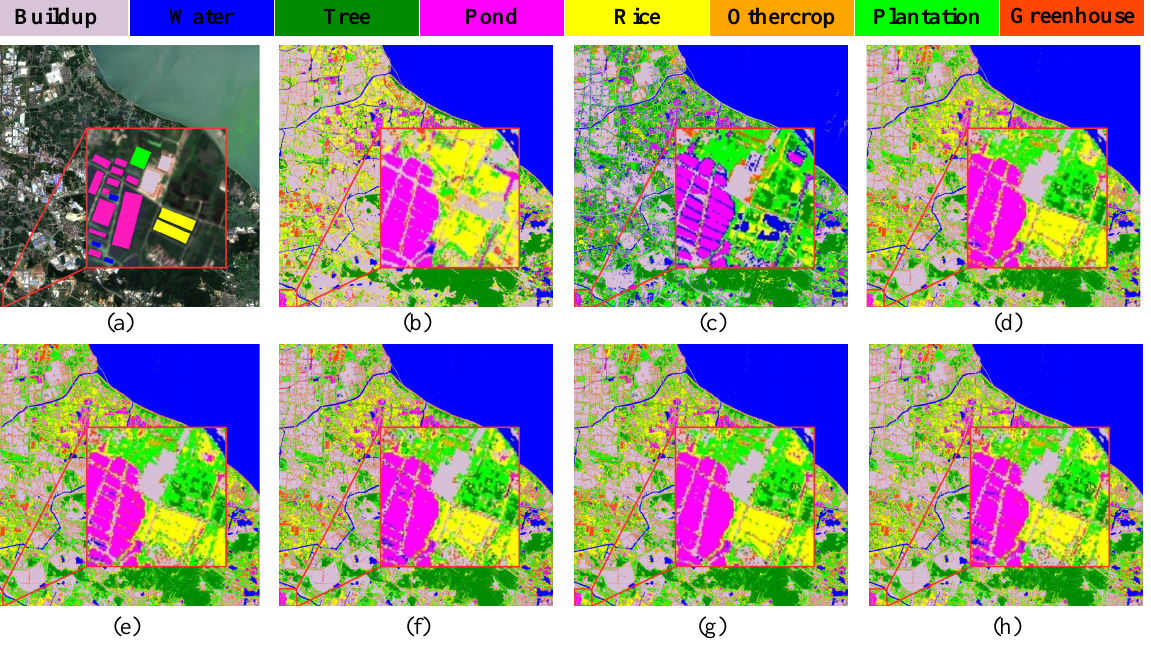
Figure 9. Classification results obtained by different models applied on Changxing County data. ( a ) Image; ( b ) SVM; ( c ) 1D CNN; ( d ) RNN; ( e ) Transformer (ViT); ( f ) SpectralFormer; ( g ) FC + 2D CNN; and ( h ) HyFormer.